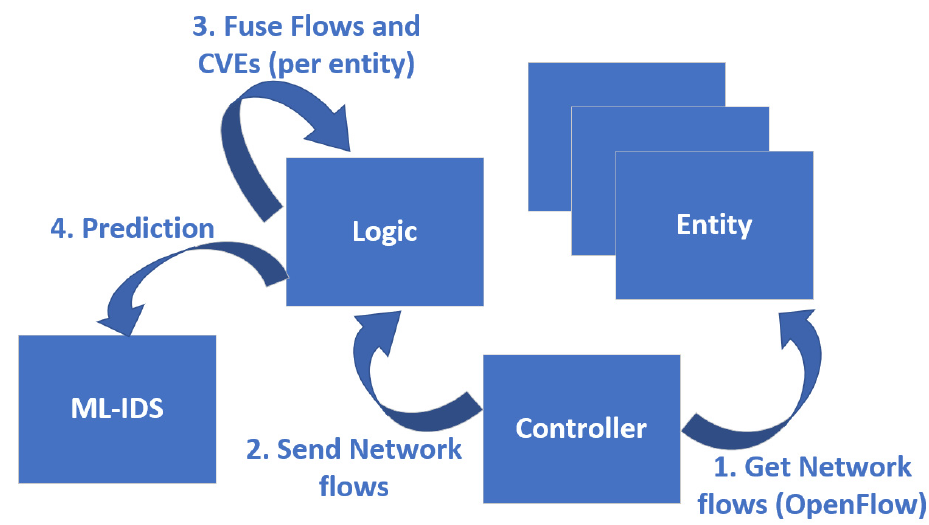
Figure 3. Detection use case conceptual diagram.